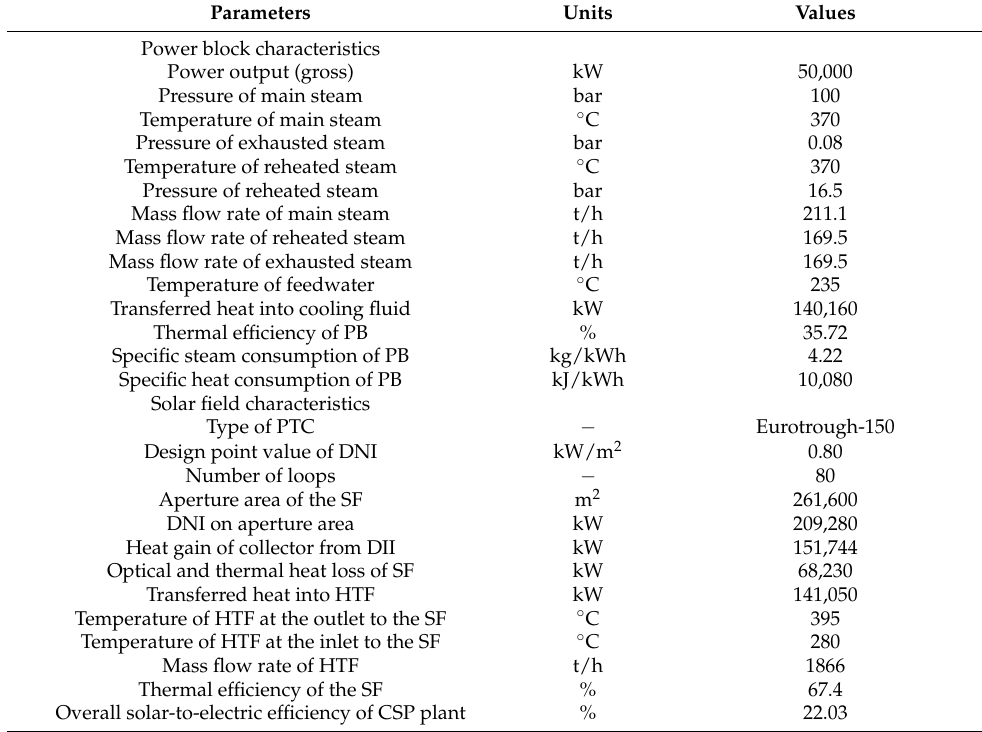
Table 4. Main parameters and operating performance of 50 MW CSP plant in nominal